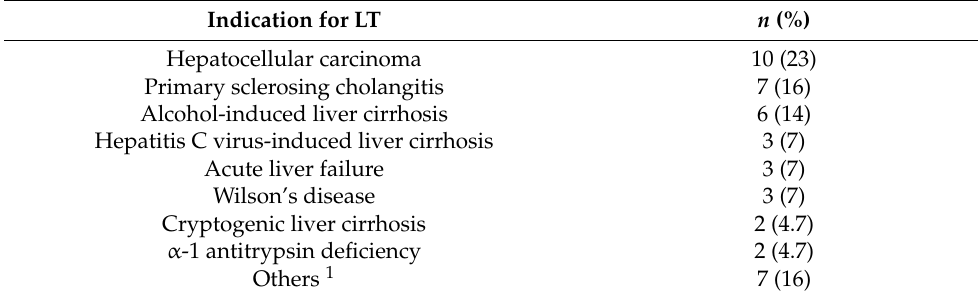
Table 2. The indication for liver transplantation is shown as absolute number n and percentage. Indication for LT